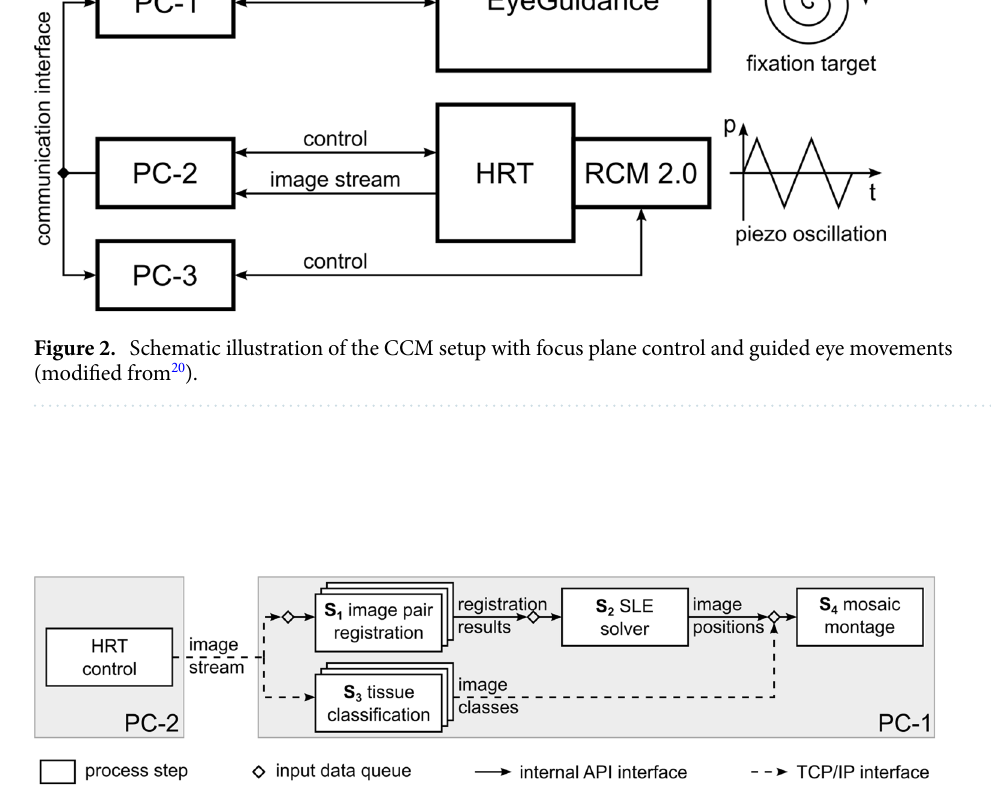
Figure 3. Image processing workflow for online mosaicking. The workflow consists of four separate functional modules that all work concurrently once data is passed through the processing pipeline. In addition, multiple concurrent instances of the modules for process steps S 1 and S 3 can process multiple data items at the same time. (SLE: system of linear